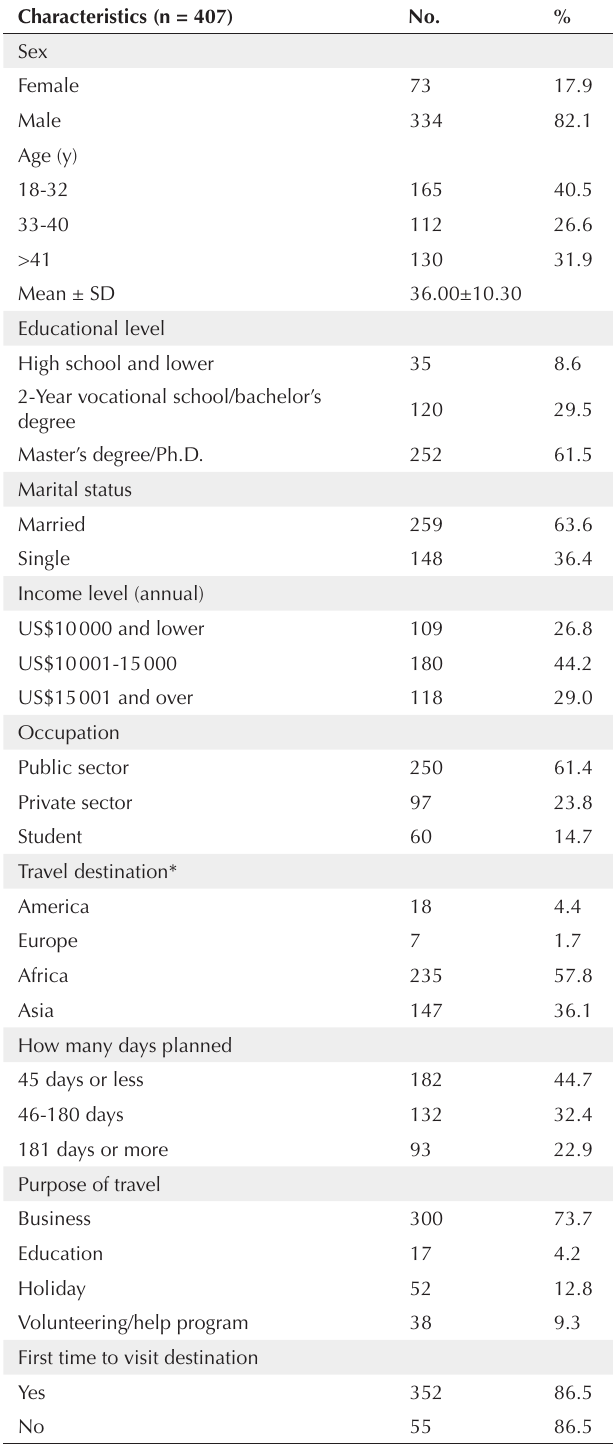
Table 1. Demographic and Travel Characteristics of the Travelers Characteristics (n =